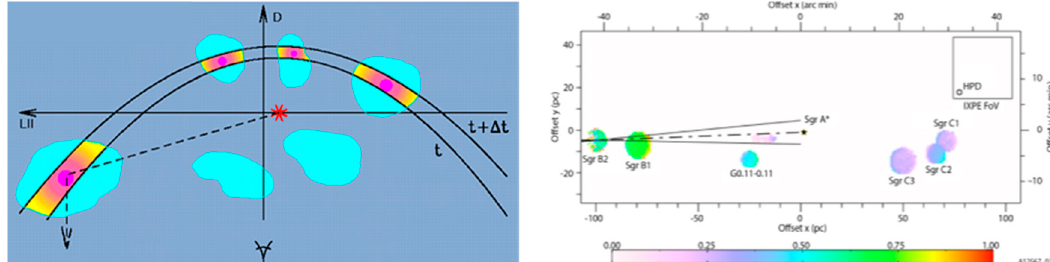
Figure 16. Left to right : flux, degree of polarization, and position angle, all versus the pulse phase for 1RXS J170849.0-400910. Blue and red curves represent QED accounted for and not accounted for, respectively. Data points and errors are for a 250-ksec observation.